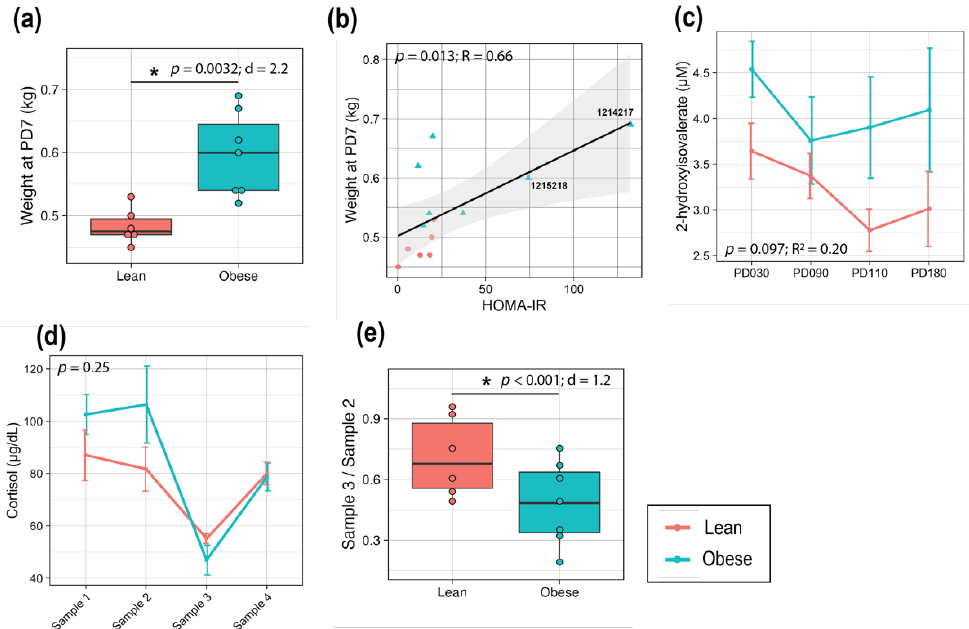
Figure 5. Maternal obesity led to larger infants at birth with altered metabolomic profiles. ( a ) Infant weight at PD7. ( b ) Correlation between maternal HOMA-IR at GD150 and infant weight at PD7. The black line represents the Pearson correlation regression line, and the gray area represents the 95% confidence interval. The seven-digit numbers correspond to Mother ID. Line plots of the concentrations of infant plasma ( c ) 2-hydroxyisovalerate from PD30 to PD180, and ( d ) cortisol over four sampling time points. ( e ) Box plot representing the suppression in plasma cortisol level made by Dex (Sample 3/Sample 2). t -tests were used to test for group differences of samples that were collected at a single time point ( a , e ) and statistical significance is indicated with a “*”. Data are expressed as the mean ± SE. A linear mixed-effects model was fit followed by ANOVA to test the group difference of samples with multiple time points ( c , d ), and pairwise comparisons were done as post hoc tests using the estimated marginal means. For box plots ( a , e ), each dot represents data from an individual animal. Top and bottom of the boxes represent the 25th and 75th percentiles respectively; the middle line represents the median; and the top and bottom whiskers represent maximum and minimum values. Points outside of the whiskers represent outliers. Red and blue dots/lines correspond to the Lean and Obese groups, respectively. Sample size is Lean = 6, Obese = 7. Abbreviations: d, R, or R 2 , effect size measurements; PD, postnatal